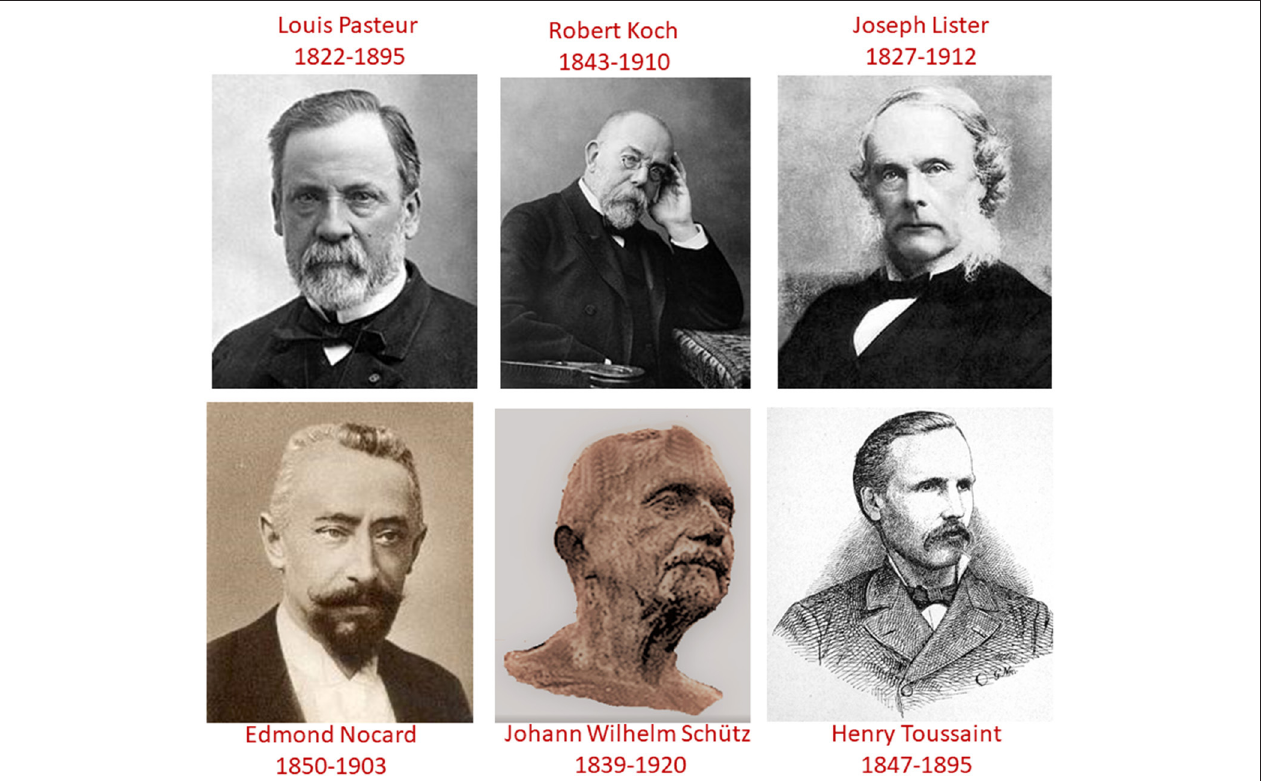
FIGURE 5 | The three early giants of microbiology (Pasteur, Koch, and Lister) and “their associated veterinarians” (Nocard, Schütz, and Toussaint). Pasteur, Koch, and Lister, the three giants, who wrote and researched the history of bacteriology and medical microbiology, had complex inter-personal relationships. This was especially so for Pasteur and Koch with Lister paying the role of mediator. These three greats established friendly professional relationships with veterinarians: notably between Pasteur and Nocard from Alfort; between Lister and Toussaint from Toulouse; and between Koch and Schütz from Berlin. The involvement of veterinarians in this Pasteurian revolution exerted a profound influence on the early history of the veterinary profession; there was immediate adoption of the new scientific paradigms, thus transforming it into a true medical profession, whose activity was henceforth based on science. This was clearly recognized by Pasteur himself during his inaugural speech welcoming in 1884 Bouley, inspector general of veterinary schools in France, as the new president of the French Academy of Sciences with these words: “ A century ago, gentlemen, you had only a modest position in the scientific world… So, gentlemen, while human medicine had confirmed its letters of nobility since the beginning of the civilized world, you were still, in the middle of the 18th century, only the farriers. There was a time, moreover, when surgeons were considered a bit like lackeys and bonesetters. We are far from these appreciations; today, in your ranks, famous names are mentioned. And now, that one of you (Bouley) becomes president of the first Academy in the world. ” If the profession owes a lot to Pasteur, the converse is also true which led Pasteur to comment: “ If I was young, and even at my age if I were able-bodied, I would go and become a student of the Alfort school. Reading veterinary books set my head on fire ” ( 51). Actually, the relationships between all six of these individuals, who were foremost in shaping our profession, were somewhat more complicated and not entirely harmonious, as detailed in Supplementary File 3